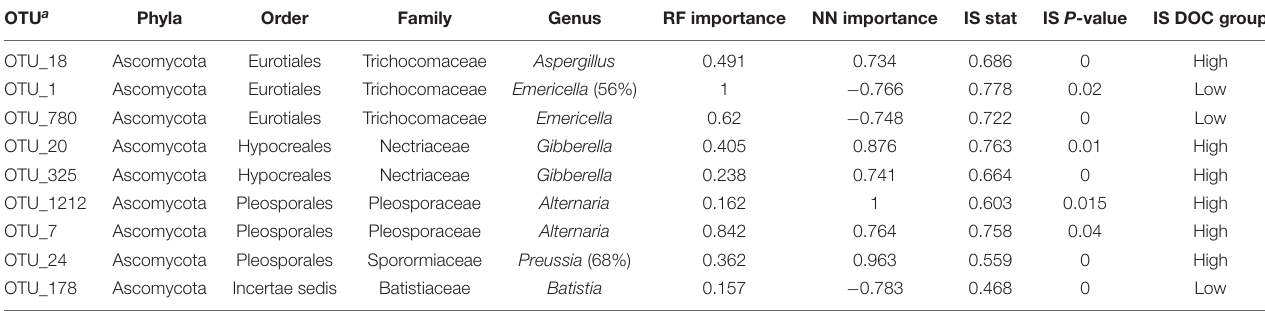
TABLE 2 | Nine fungal taxonomic features consistently associated with DOC concentration were determined from random forest (RF), neural network (NN), and indicator species (IS) analyses. OTU a